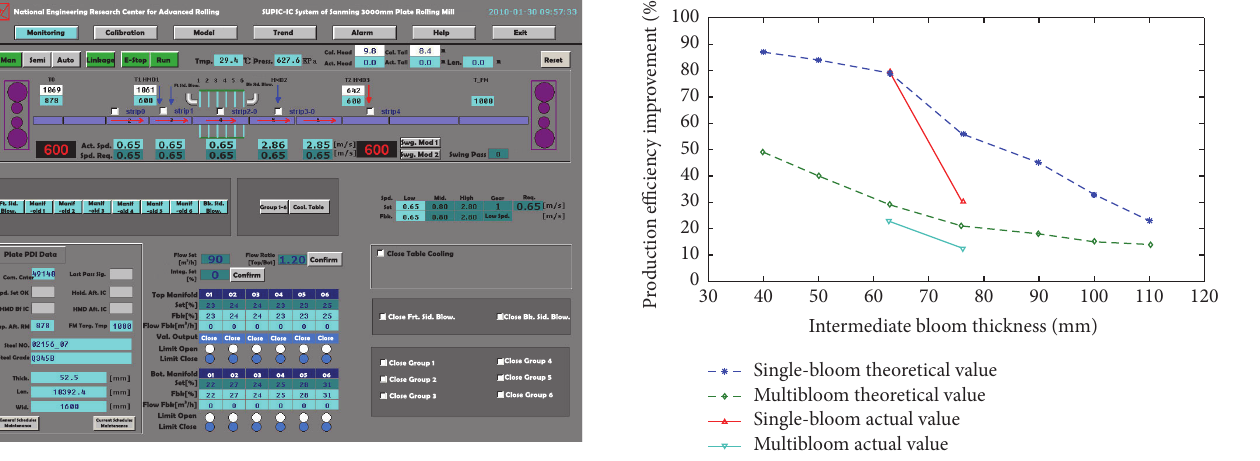
Figure 5: Home screen of HMI.